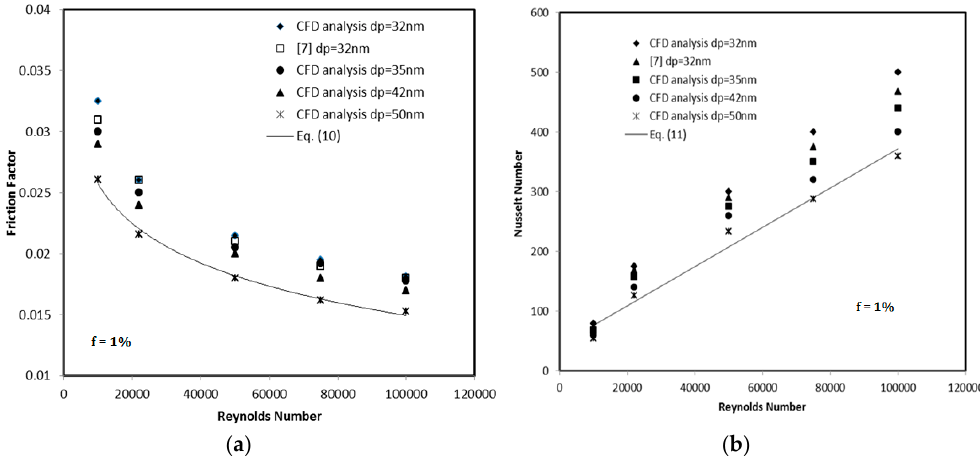
Figure 4. The effect of particles size diameter. ( a ) The effect of particle size diameter on friction factor with Reynolds number; ( b ) the effect of particles size diameter on Nusselt number with Reynolds